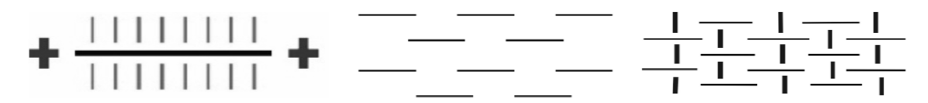
Figure 1. Bentonite clays behavior: charged particle, under forced flow and at rest [Zhang et al.,